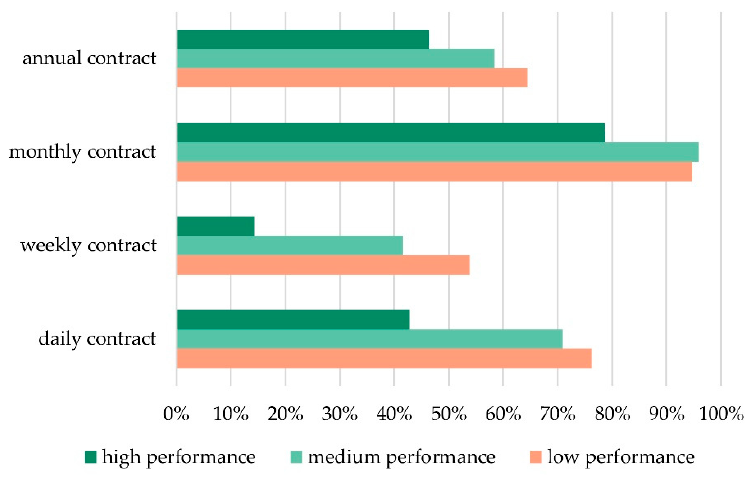
Figure 6. Types of contracts offered by performance category (percentages calculated from the total number of answers received for each type of contract).